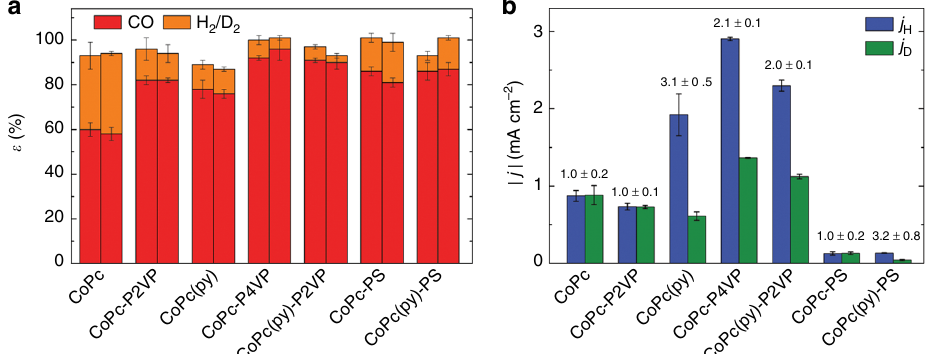
Fig. 4 CO 2 reduction performance in protic and deuterated solutions. a Faradaic ef fi ciencies ( ɛ ) of 2-h controlled potential electrolyses at − 1.25 V vs. SCE for H 2 /D 2 (orange) and CO (red) in protic electrolyte (left bar), and in deuterated electrolyte (right bar). b Measured current densities at − 1.25 V vs. SCE in protic electrolyte (blue bar) and deuterated electrolyte (green bar) for each of the systems shown in Fig. 2. Kinetic isotope effect values are listed above the bars and also summarized in Table 1. All reported values are averages from three or more independent measurements, and all errors are given as standard